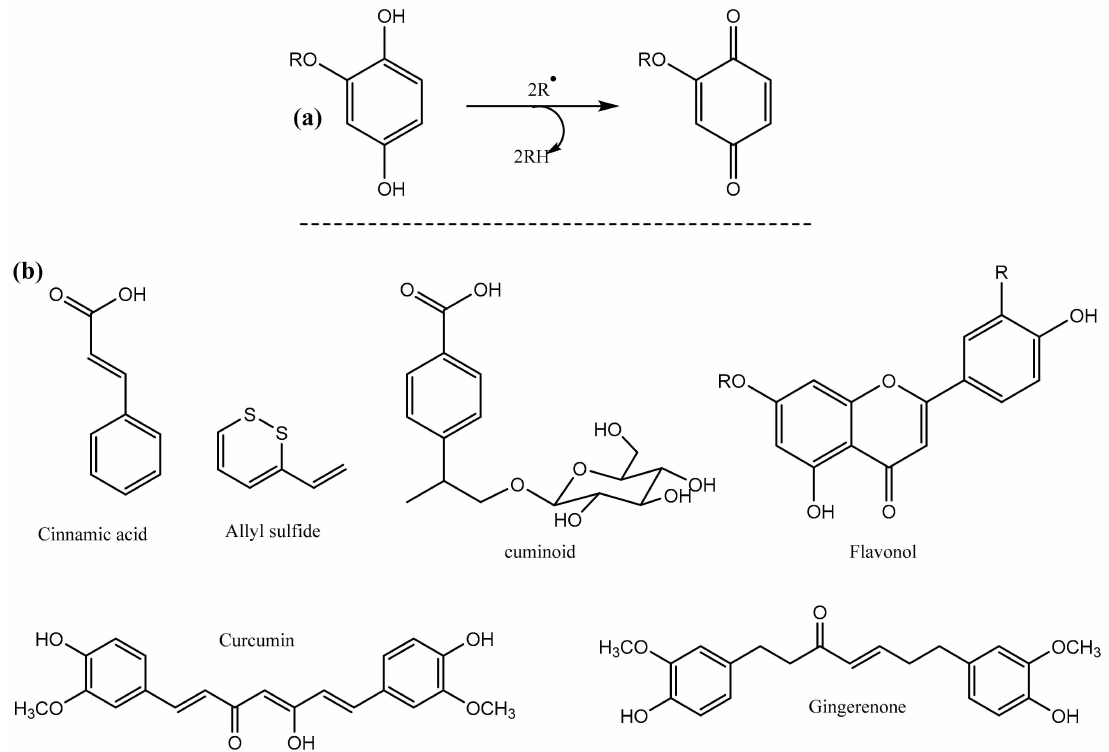
Figure 1. ( a ) Reaction of quinone mediator formation after interaction with radical species and ( b ) Structures of flavonoid and active phenolic compounds found in cinnamon, garlic, cumin, turmeric and